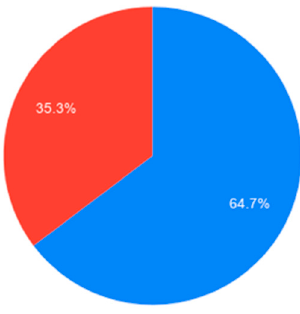
Figure 2. Have you heard about ISO 7730?